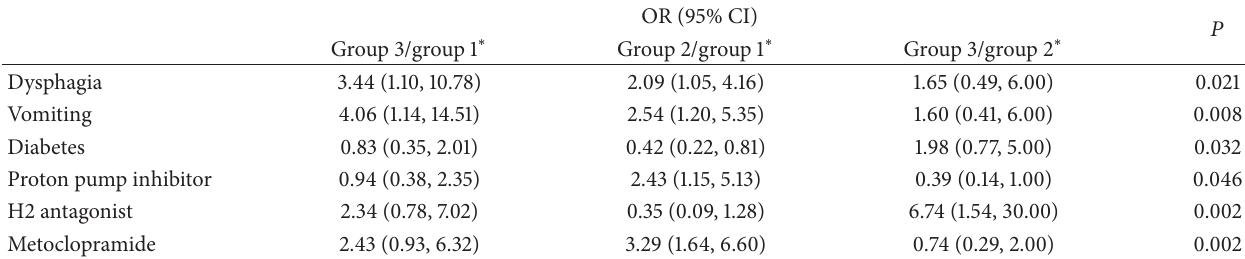
Table 2: Independent predictors of prolonged gastric emptying.